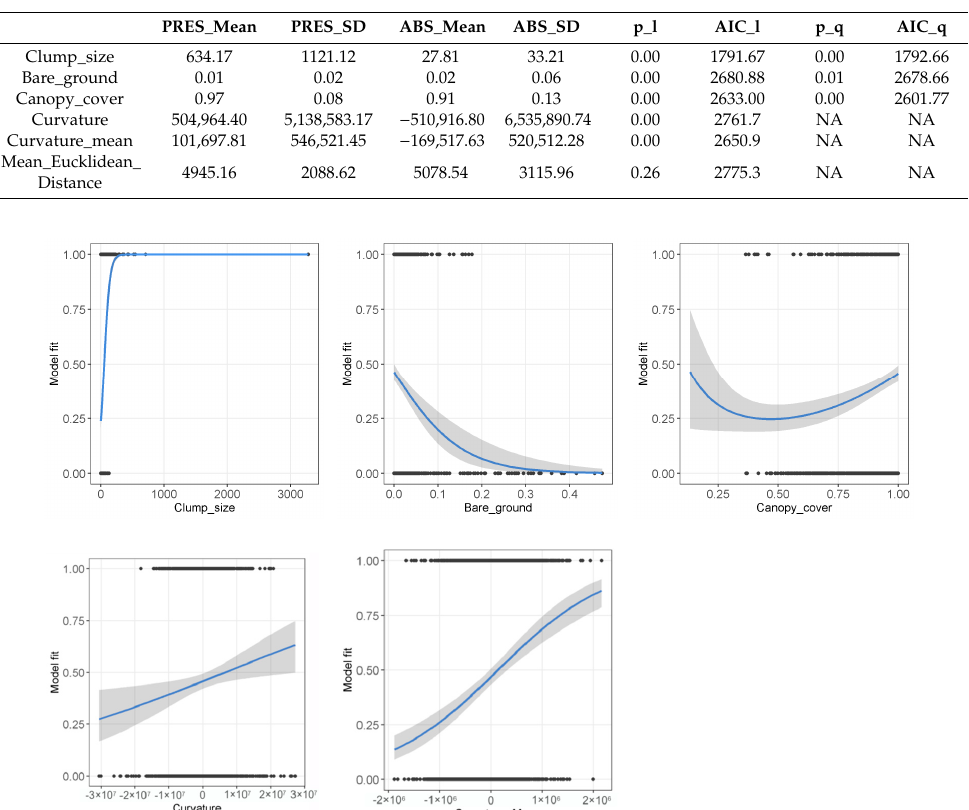
Table A2. Variables tested and retained (in bold) in the “deadwood-uncertainty model”, a generalized linear model GLM predicting the probability of standing deadwood being correctly classified. Variables are presented with their mean and standard deviation (SD) for correctly (PRES) and falsely (ABS) classified deadwood pixels. Also provided are the p-value and AIC of univariate models including the linear (l) and quadratic (q) term of the variable. Variable codes and descriptions are listed in Table 3.